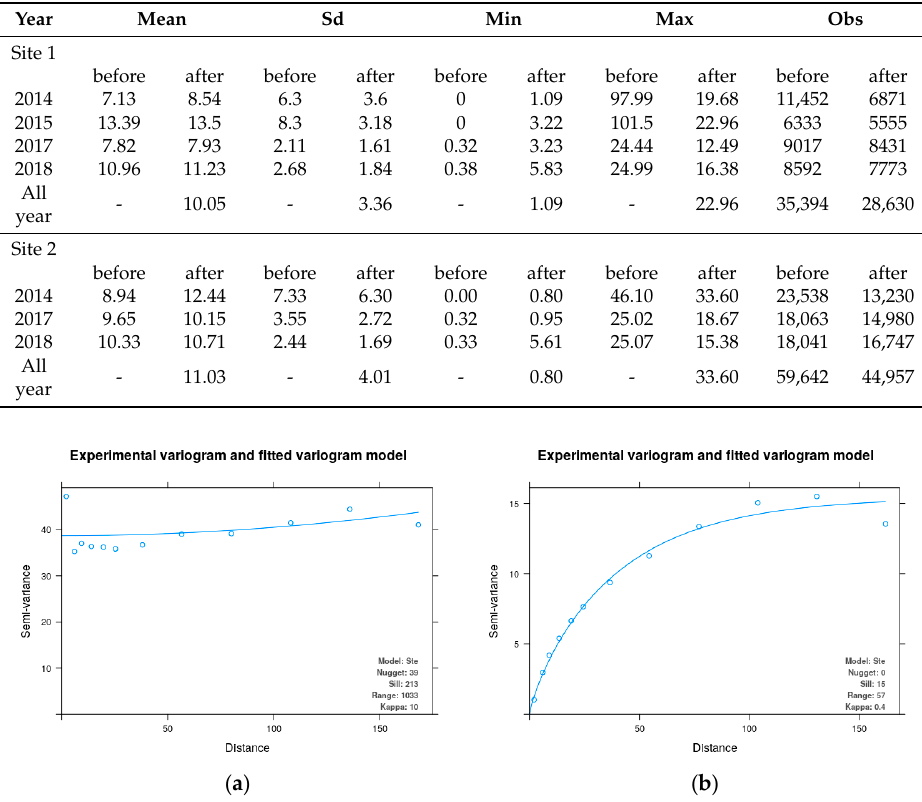
Table 4. Statistics of yield monitor data values before and after-spatial filtering.